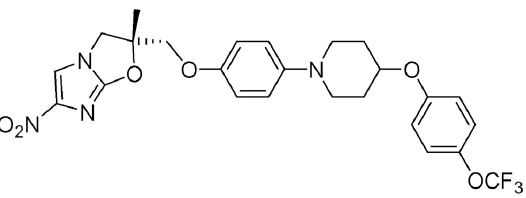
Figure 2. Structural formula of delamanid.